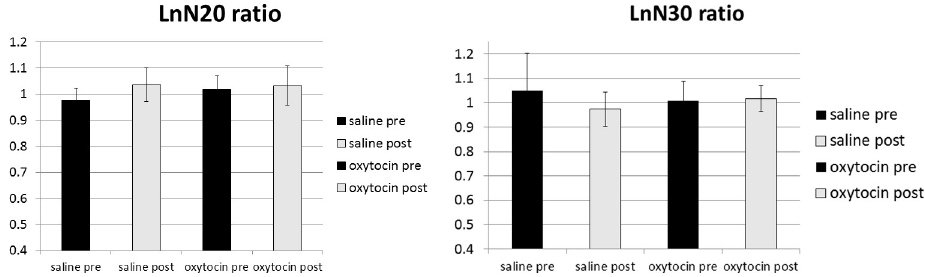
Fig 3. Mean and standard deviation of the equivalent current dipole strength of logN20 m and log N30 m ratios (the ratios of log amplitudes during moving image observation to those during static image observation) before and after placebo or oxytocin administration. The vertical lines indicate the standard deviation ( � p < 0.025). (A) ANOVA indicated a significant main effect of time course (preadministration vs. postadministration) for the N20 ratio but no significant main effect of treatment (oxytocin vs. saline) or treatment x time course interaction. (B) There was no significant main effect of treatment or time course, but a significant treatment x time course interaction was observed for the N30